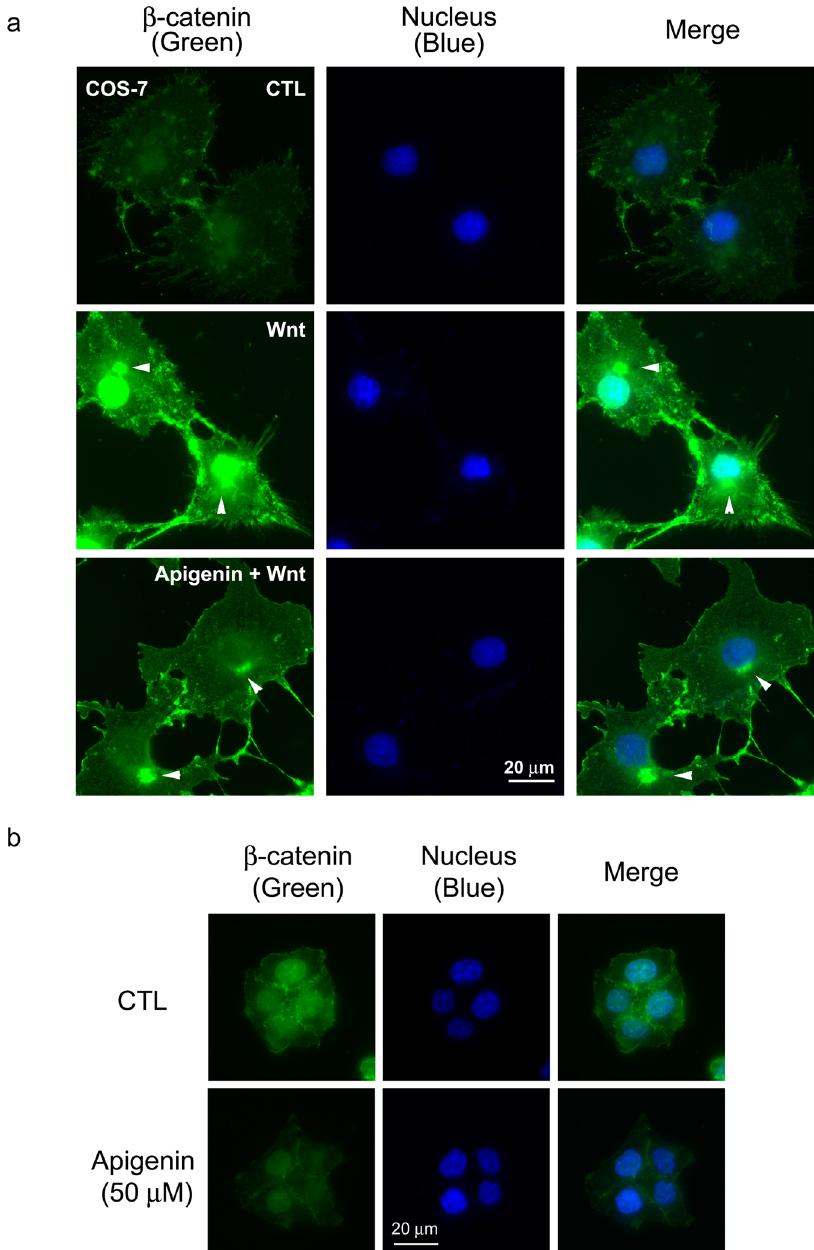
Figure 6. Apigenin reduces the levels of β -catenin in Wnt-stimulated COS-7 cells and HCT-116 cells by immunofluorescent staining. ( a ) Apigenin decreases the levels of β -catenin in Wnt-stimulated COS-7 cells. Cells were treated with control-conditioned medium (CTL), Wnt-3a-conditioned medium (Wnt), or 50 μ M of apigenin in Wnt-3a-conditioned medium (Apigenin + Wnt) for 20 h, and cells were processed for immunofluorescent staining with β -catenin antibody (labeled in green). Cell nuclei were stained with DAPI (labeled in blue). Arrowheads showed the staining of β -catenin on microtubule-organizing center (MTOC). ( b ) Apigenin decreases the levels of β -catenin in HCT-116 cells. Cells were either incubated in culture medium (CTL) or treated with 50 μ M of apigenin in culture medium for 22 h and processed for immunofluorescent staining with β -catenin antibody (labeled in green). Cell nuclei were stained with DAPI (labeled in